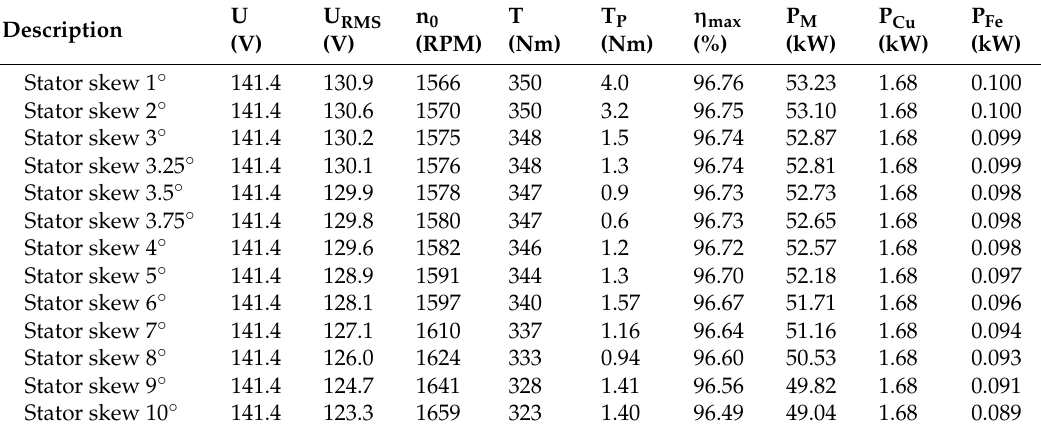
Table 12. The effect of twisting the stator coils on the obtained ERPMSM